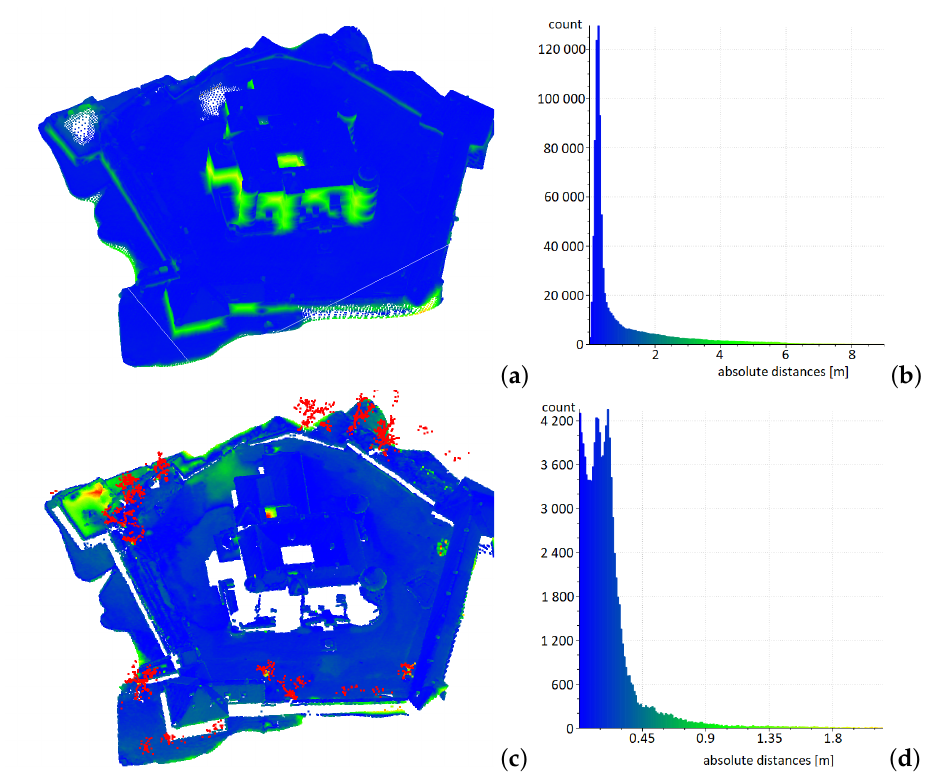
Figure 16. Distance error (RMS) for reconstructed model and reference LAS ISOK: reconstructed model to LAS ISOK – point-to-point mapping ( a ) and histogram ( b ); LAS ISOK to reconstructed model – point-to-mesh mapping ( c ) and histogram ( d ). On the vertical axis the number of points is marked, on the horizontal axis – the distance in